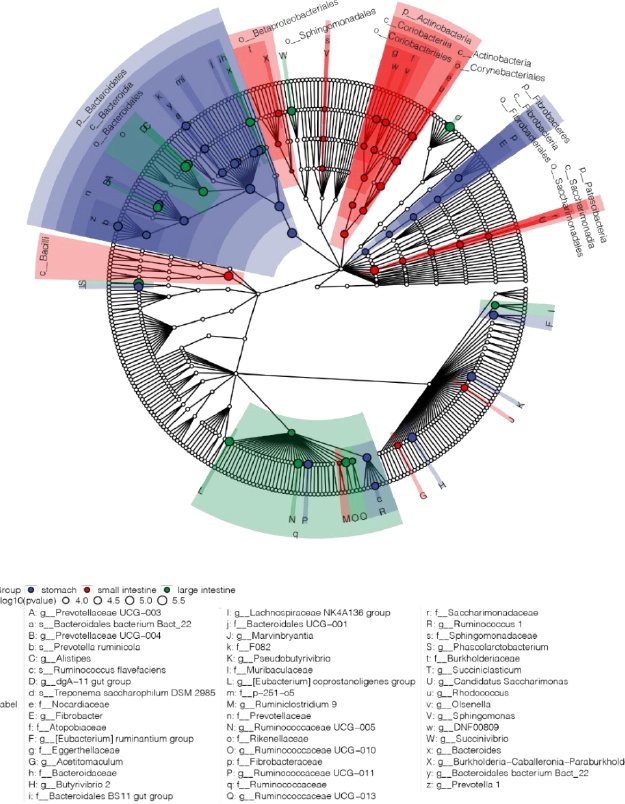
Figure 3. Cladogram of the characteristic bacteria of the stomach, small intestine, and large intestine. Only characteristic bacteria with a relative abundance higher than 1% in at least one group are displayed in cladogram, and bacteria were colored with corresponding colors (stomach: blue; small intestine: red; and large intestine: green).